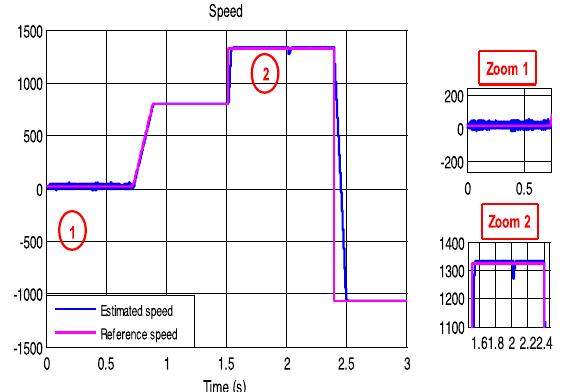
Fig. 10 FL-DTC estimated speed response